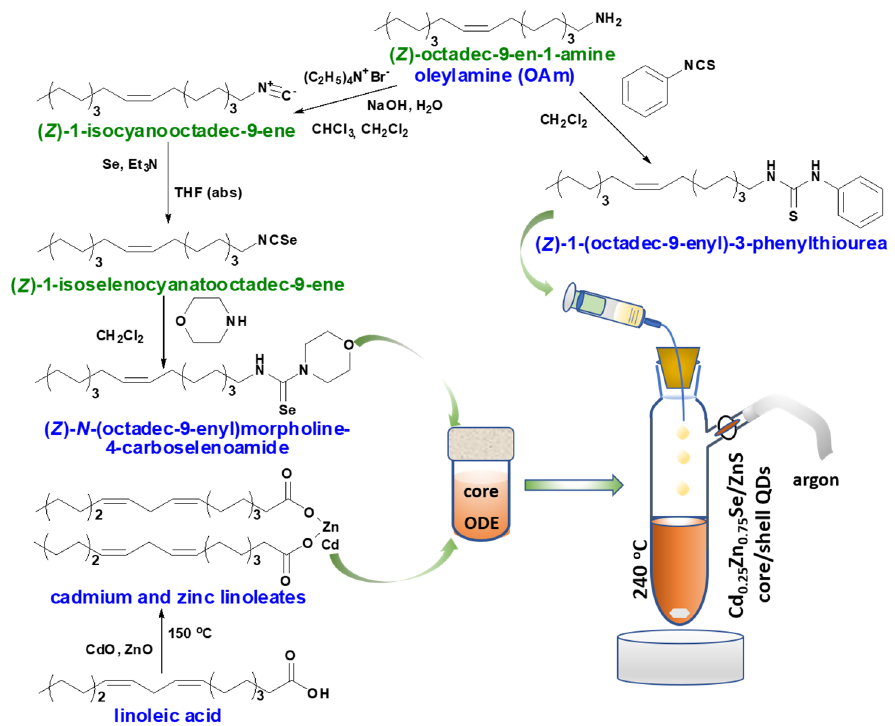
Figure 1. Schematic overview of the Cd 0 . 25 Zn 0 . 75 Se/ZnS (1–5 MLs) core/shell QDs